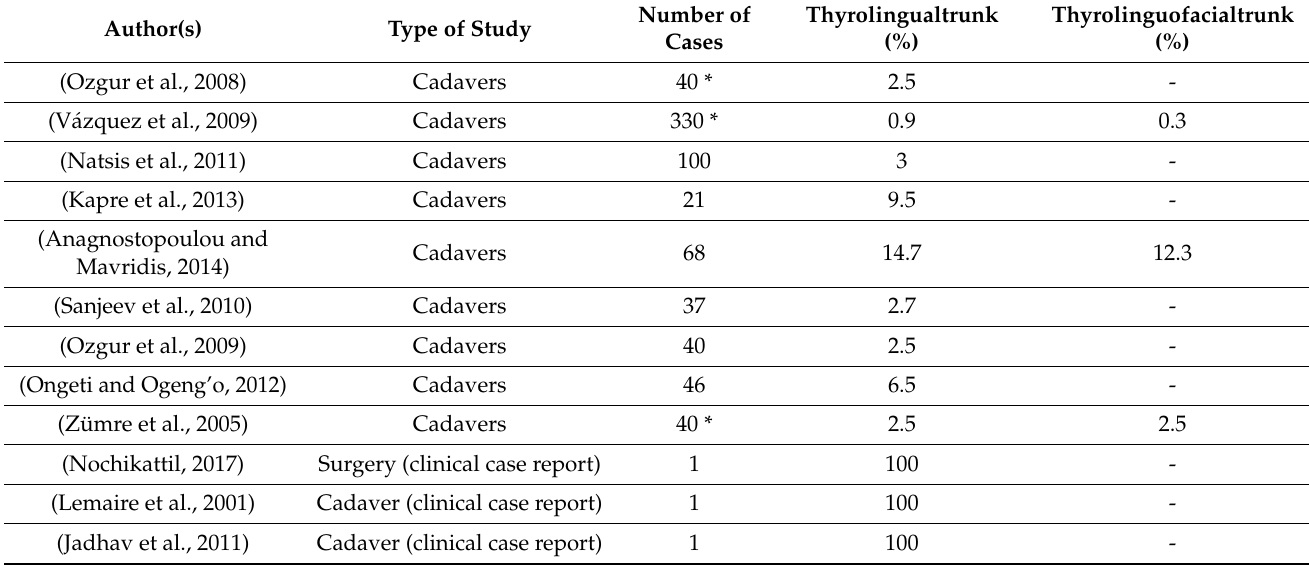
Table 3. Available data concerning the STA origin from thyrolingual and thyrolinguofacial trunk.